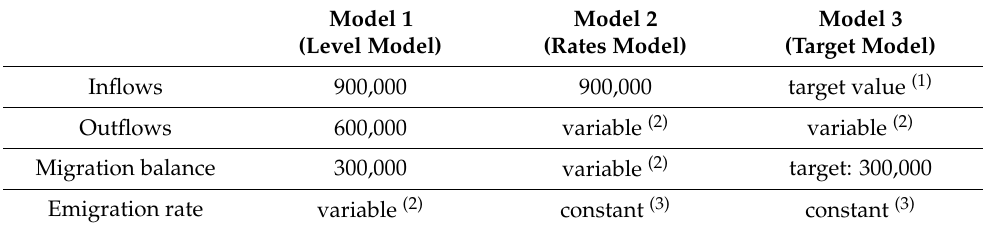
Table 1. Scenario